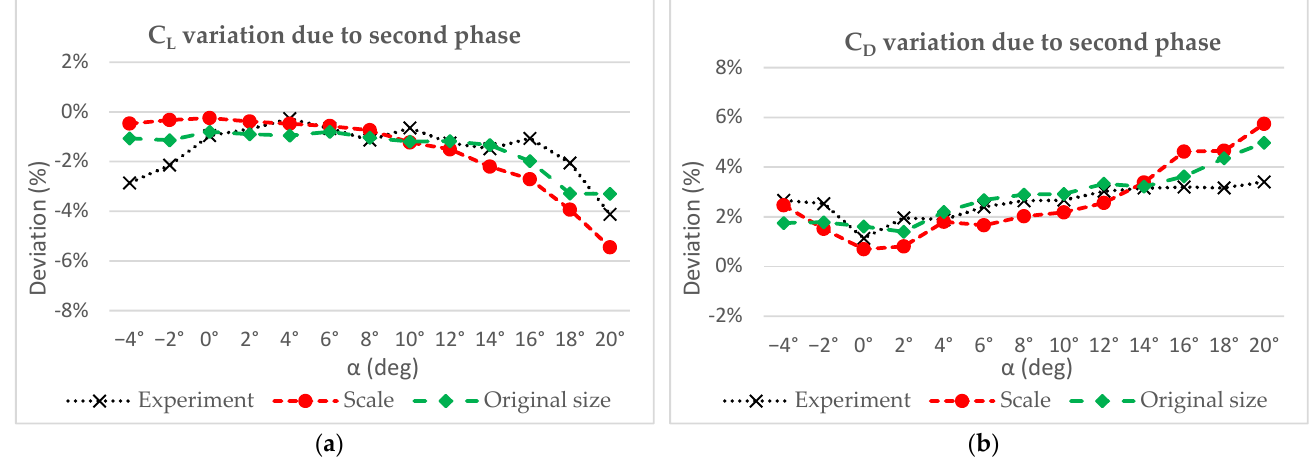
Figure 12. Deviation due to the presence of second phase: ( a ) lift coefficient; ( b ) drag coefficient. In Table 1, L/D degradation is presented for both the numerical simulations and the experiment conducted in the subsonic wind tunnel. The general tendency shown is a de- cline in the aerodynamic efficiency due to the presence of the second phase. There is very good agreement among the three cases concerning the mean deviation of the aerodynamic e ffi ciency, presenting values of − 3.98%, − 4.03%, and − 4.15% for the experiment and the simulations of scaled and original models, respectively. This means that the wing experi- enced 4% loss, on average, of its aerodynamic efficiency due to the existence of the second phase. The highest percentage degradation for all three cases appeared at 20° angle of attack, while the lowest values were obtained at 0° and 2°. What needs to be mentioned here is that, from − 4° to 0° and 2°, the percentage deviation decreased, whereas the general ten- dency from 2° until 20° was an increase, for both the numerical simulations and the ex- periment. Table 1. L/D percentage degradation due to the existence of second phase, for the experimental wing model and the two simulation wing models.